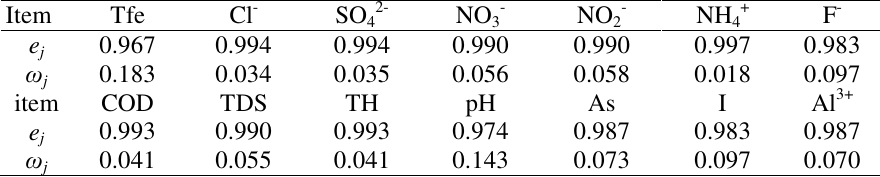
Table 3. Information entropy and entropy weight of